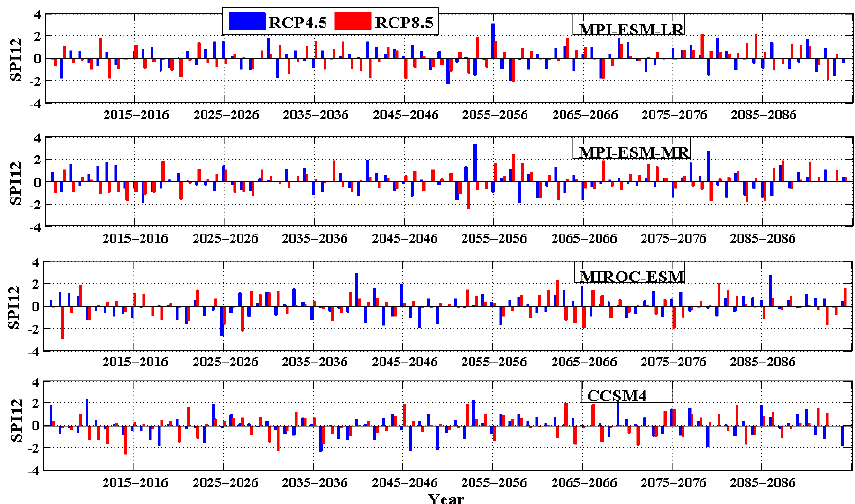
Figure 14. Future time series of SPI-12 (long-term scale) for rainfall projected by the four models and two scenarios (RCP4.5 and RCP8.5) when the QM approach is applied.